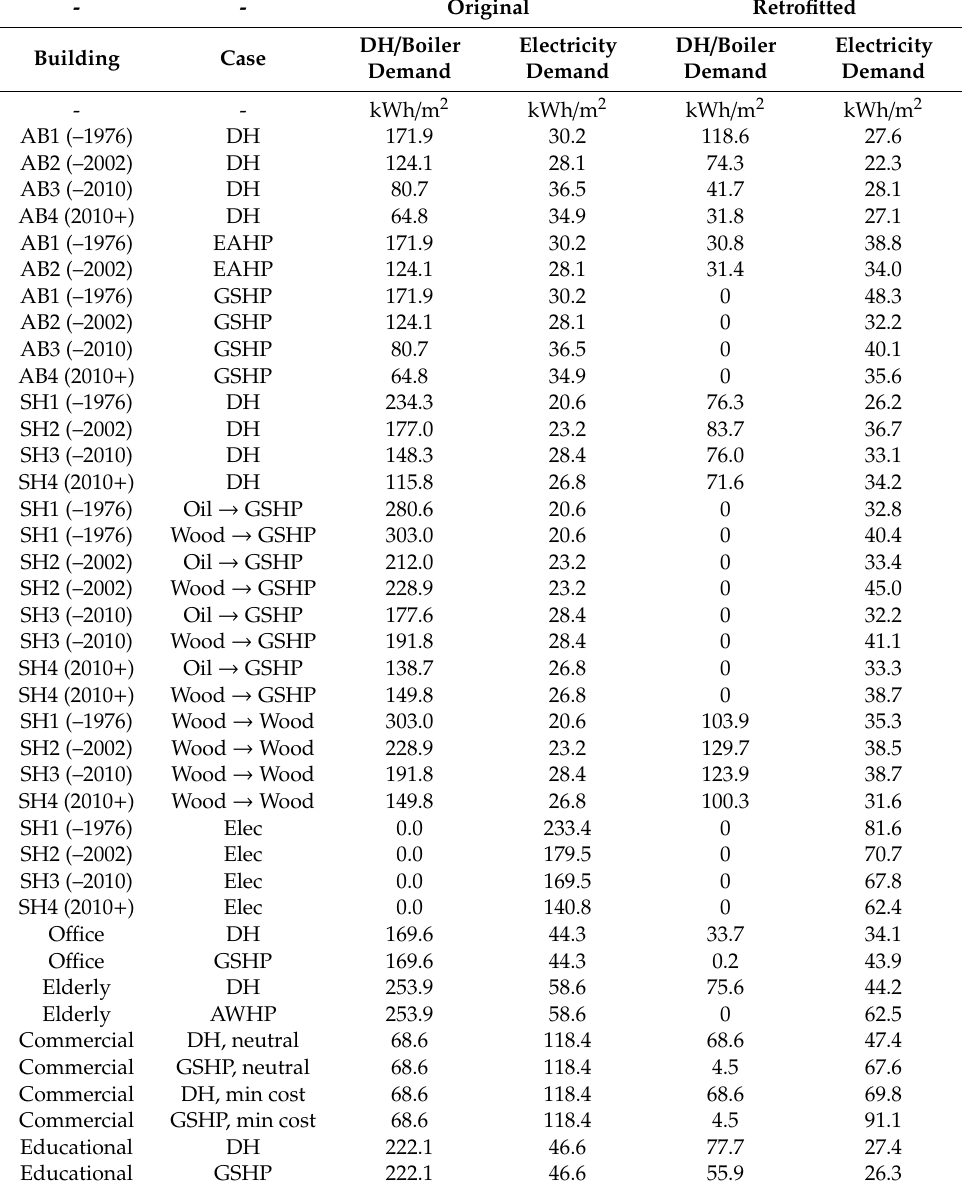
Table A1. Energy demand in the presented buildings before and after